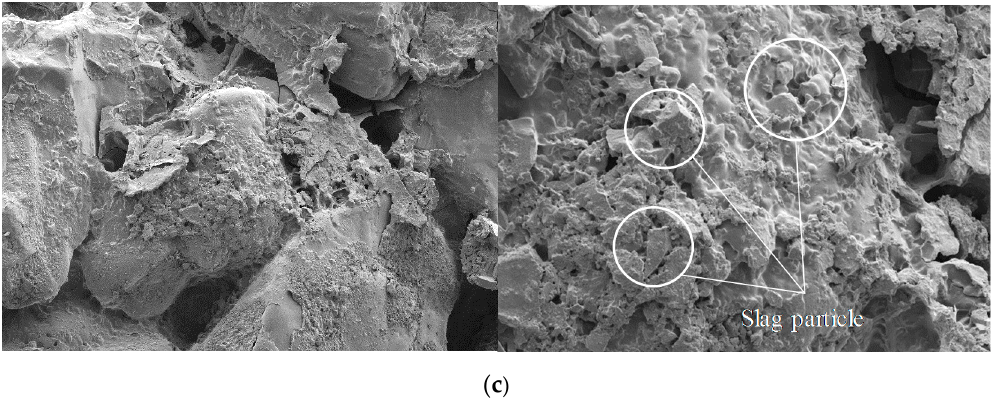
Figure 7. Results of SEM image analysis (Left: x100, Right: x400). ( a ) Scanning electron microscope (SEM) images of STD samples, ( b ) SEM images of MOD samples, ( c ) SEM images of MBS samples.